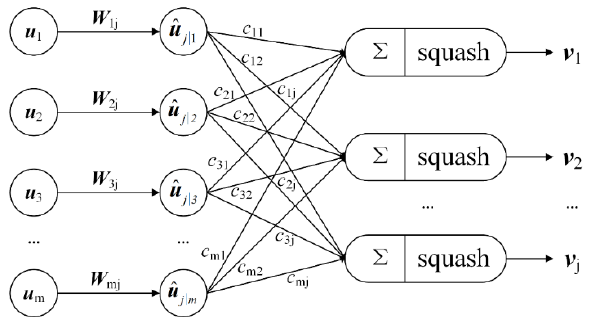
Figure 4. The computational process of the capsules. Algorithm 1: Dynamic routing